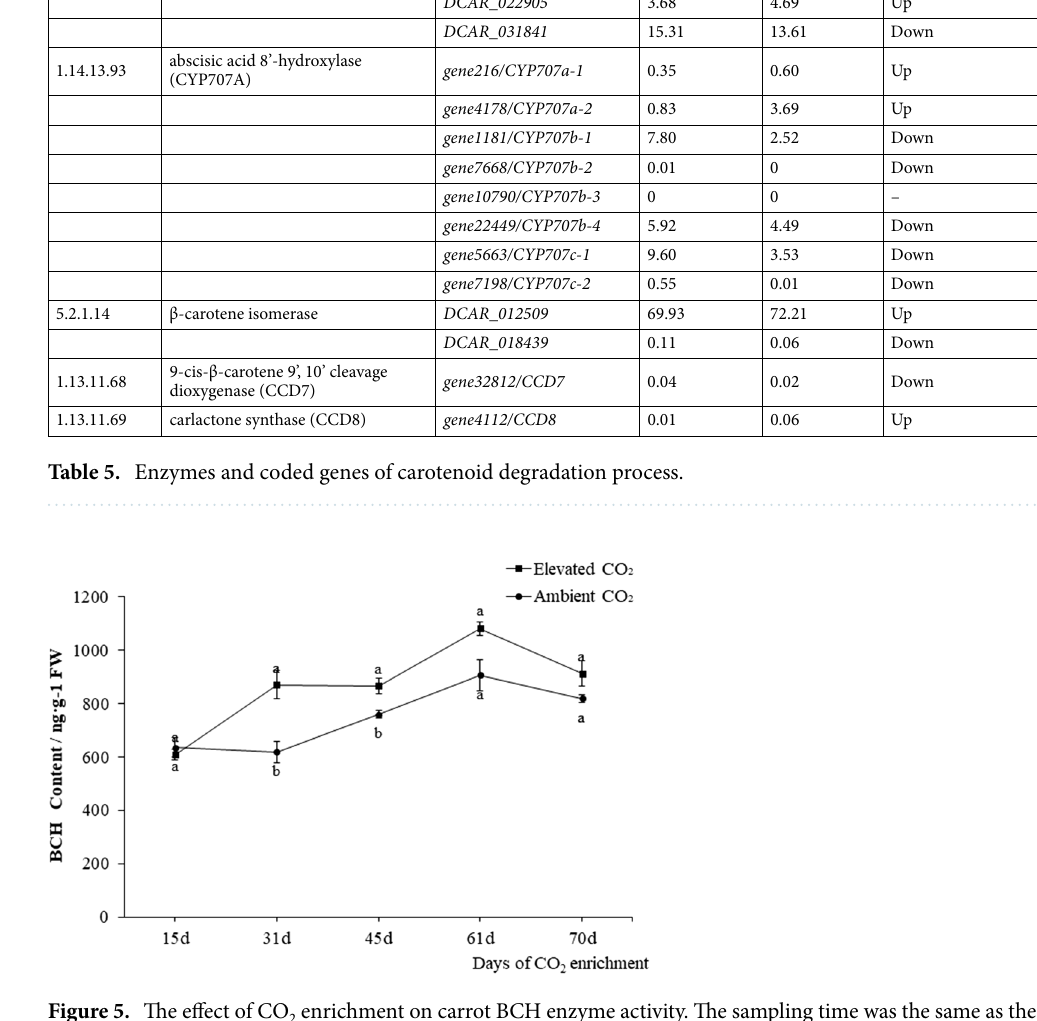
Figure 5. The effect of CO 2 enrichment on carrot BCH enzyme activity. The sampling time was the same as the biomass measurement time, but samples were taken from other